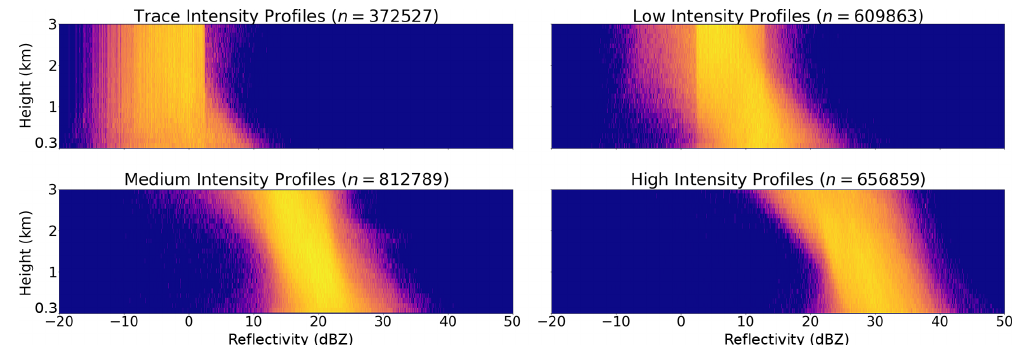
Figure 3. K -means cluster reflectivity intensity-classes of vertical profiles from the MRR instruments at all sites. A total of 2452038 vertical profiles are organized by reflectivity intensity (dBZ) into k = 4 precipitation intensity subsets. The four groups were selected using the within-cluster sum of squared errors of the elbow